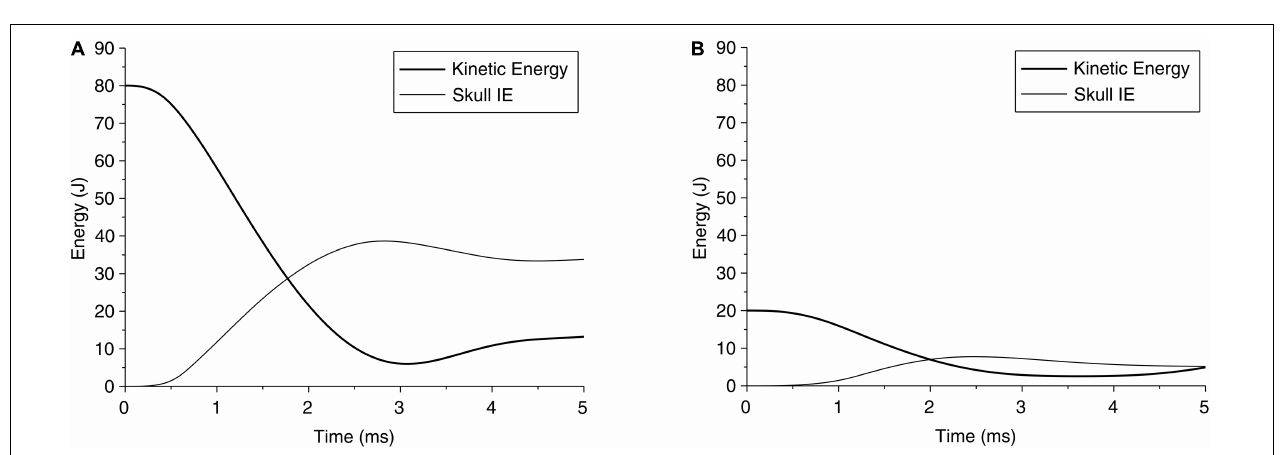
FIGURE 4 | The displacement components of the center of gravity of the head are shown for (A) case 1 and (B) case 2. The axes are shown in the head FE model.